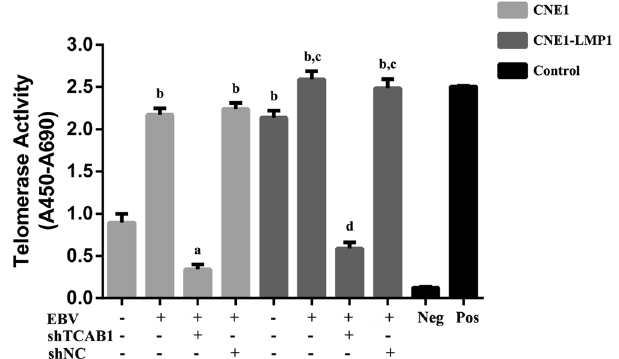
Figure 3. TCAB1 is involved in the promotion of telomerase activity induced by EBV. A telomerase assay was performed using telomerase PCR-ELISA. A lysate of 293 cells was heated at 85 °C for 10 min as the negative control; the unheated lysate was used as the positive control. The error bars represent the mean ± SD values. The statistical analysis was performed using Student’s t test ( a P < 0.05, b P < 0.01, comparing with EBV-negative CNE1; c P < 0.05, d P < 0.01, comparing with EBV-negative CNE1-LMP1). Telomerase was activated by EBV in CNE1 and CNE1-LMP1 cells, and inhibited by TCAB1 depletion in EBV-positive